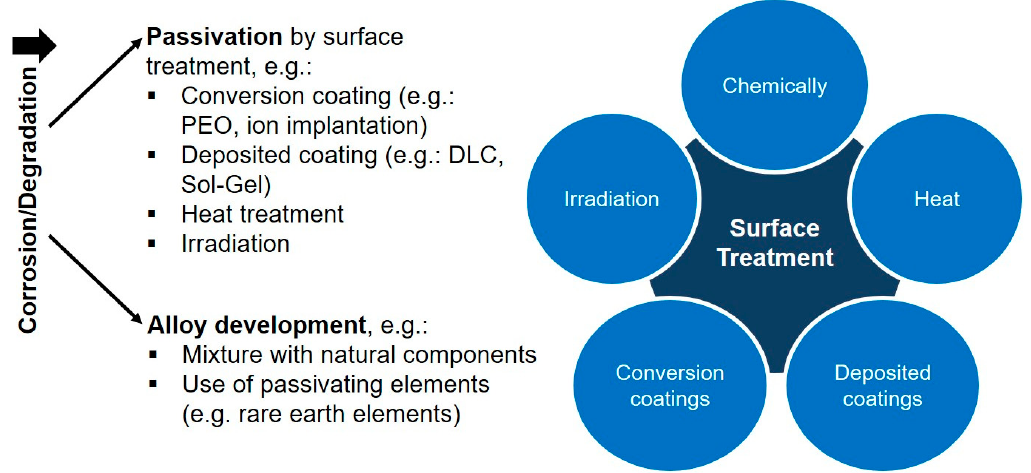
Figure 1. Common strategies to passivate magnesium for in vitro/in vivo application.